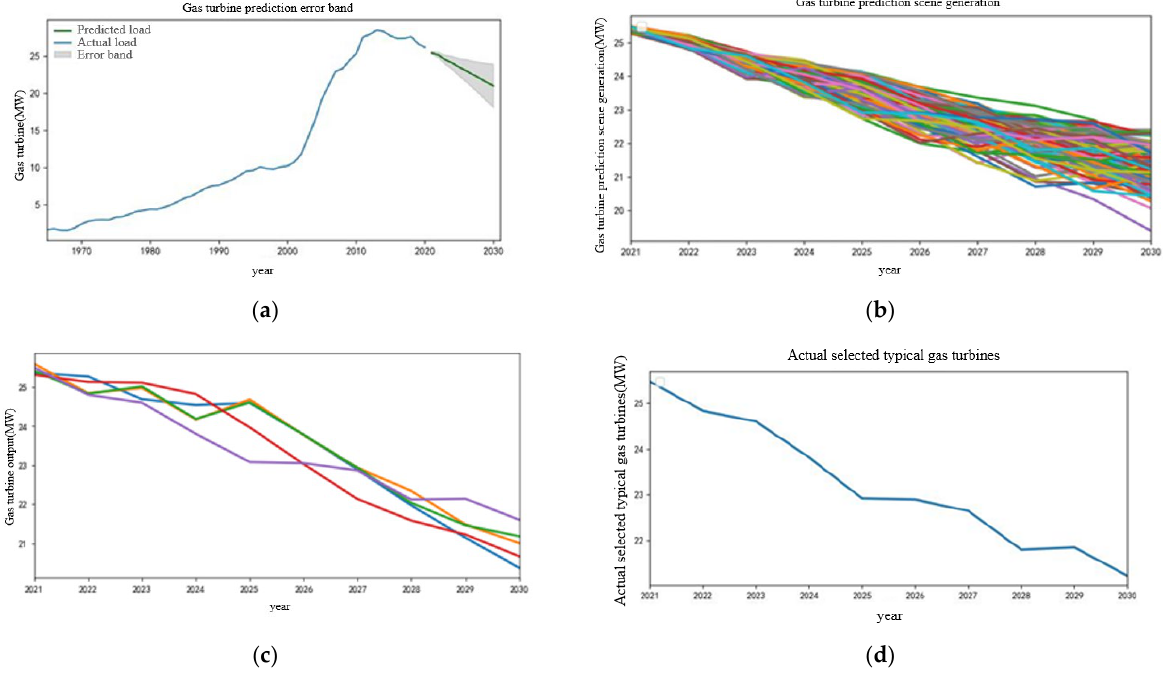
Figure 7. Gas turbine output prediction results. ( a ) Gas turbine prediction error band. ( b ) Gas turbine prediction scene generation. ( c ) Gas turbine output scenarios for the next 10 years after reduction. ( d ) Actual selected prediction curve of gas turbine.